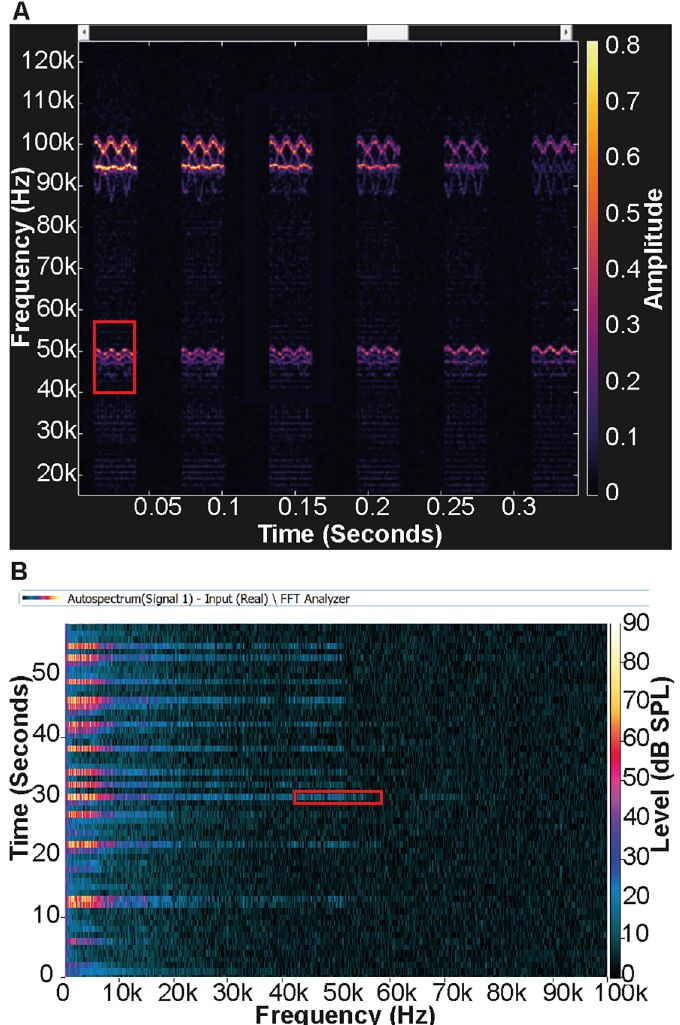
Figure 2. Spectrograms comparing the Avisoft and PULSE systems in relation to operation of walkie-talkie radios. A) The Avisoft system detected a multi component frequency modulated noise centred at approximately 50 kHz and 100 kHz. B) The PULSE system did not detect any noise at 100 kHz. The red boxes in (A) and (B) highlight comparable frequency ranges in each spectrogram. Whilst the PULSE system did measure a low-level noise in this range, it is likely related to harmonics of the higher-level audible beep in the 1 – 7 kHz